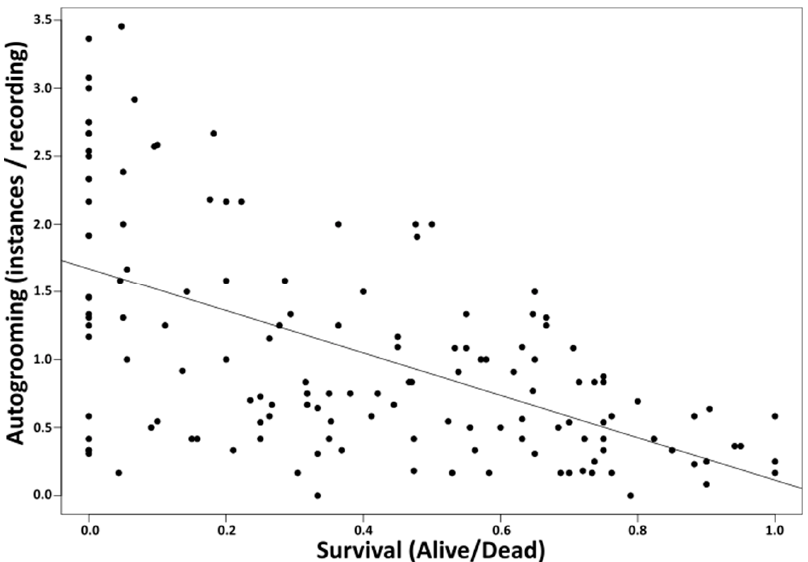
Figure 3. Autogrooming and survival. Colonies that show higher mortality upon exposure to pathogens express higher levels of autogrooming than colonies with higher survival.